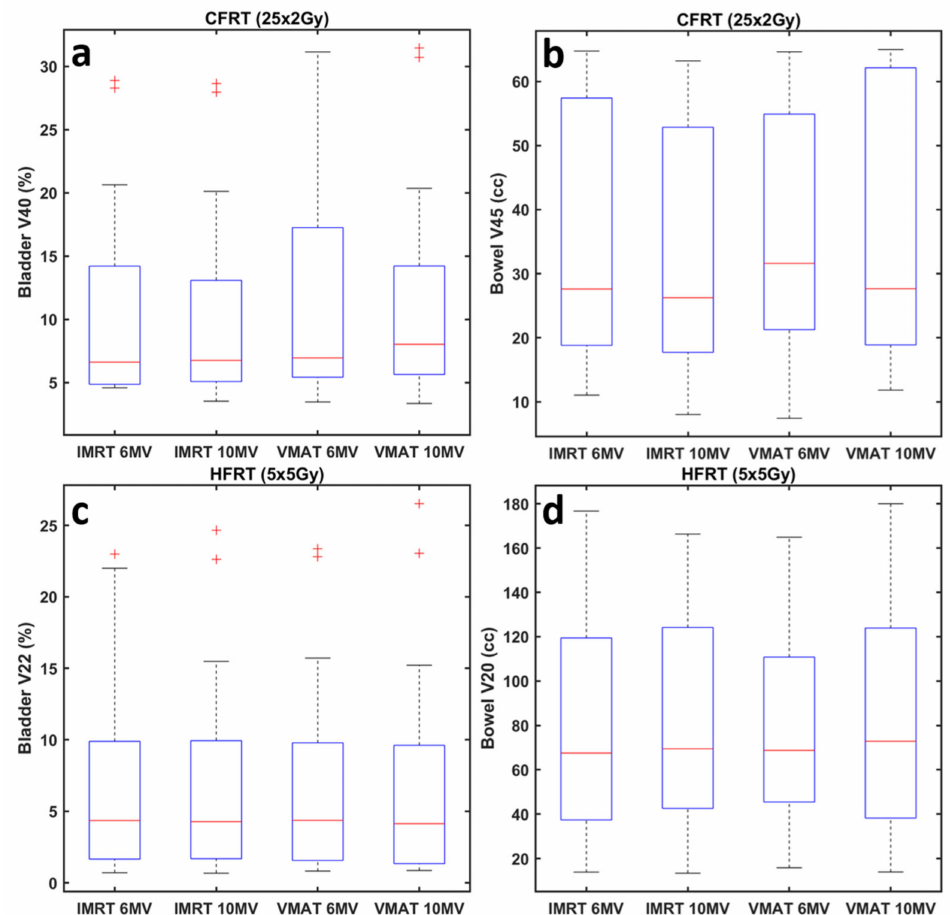
Figure 2. Box-and-whisker plots derived from all dose distributions included in this study, related to clinically used dose–volume metrics for the ( a , c ) bladder and ( b , d ) bowel. For the ( a , b ) CFRT (25 × 2 Gy) treatment protocol, ( a ) V 40 of the bladder and ( b ) V 45 of the bowel are shown, while for the ( c , d ) HFRT (5 × 5 Gy) ( c ) V 22 of the bladder and ( d ) V 20 of the bowel were selected for illustration. Red lines indicate the median value within the corresponding dataset, whereas blue boxes range from the first to the third quartile. Whiskers depict the remaining data or extend up to 1.5 times the interquartile range in either direction. In each dataset, remaining outliers (if any) are shown by the red